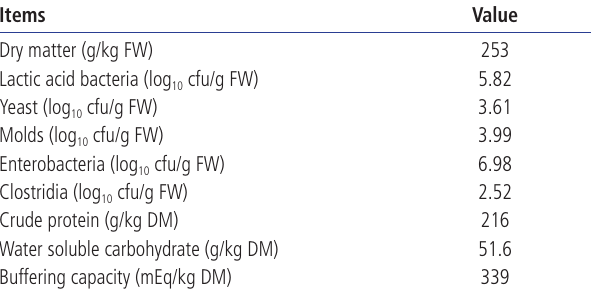
Table 1. Chemical composition and microbial populations of alfalfa before ensiling